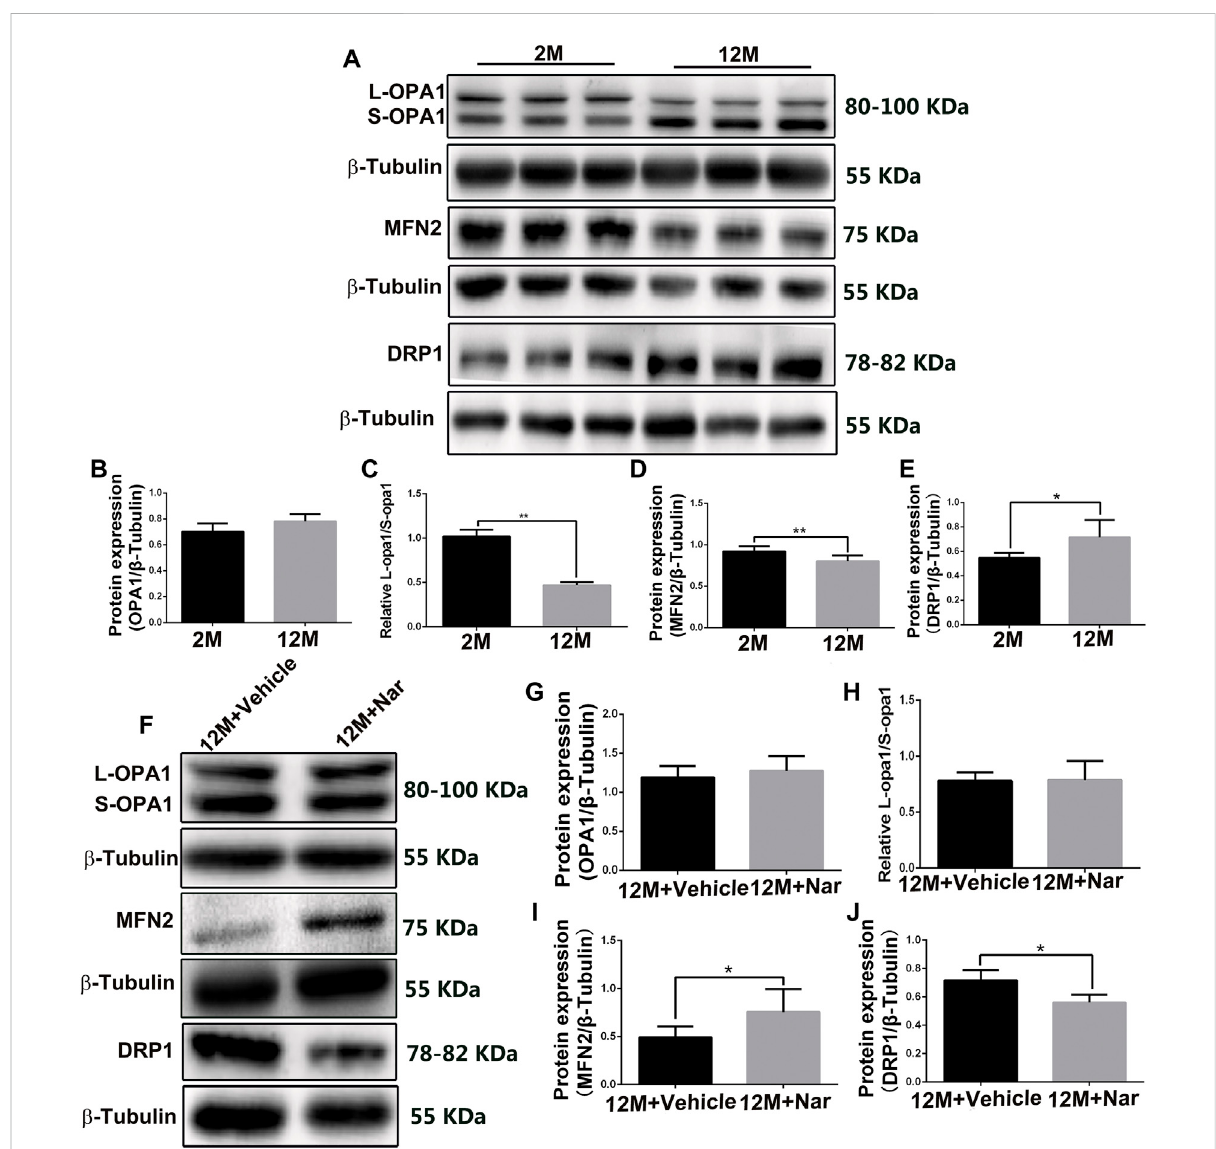
FIGURE 3 Naringeninpromotedmitochondrialfusionanddecreasedmitochondrialfragmentationinagingmice. (A) RepresentativewesternblotofOPA1, MFN2, and DRP1 at different ages. Graphic representation of average fold changes in (B) OPA1, (C) L-OPA1/S-OPA1, (D) MFN2, and (E) DRP1 protein expression. (F) Representative western blot of OPA1, MFN2, and DRP1 in treatment with naringenin, Graphic representation of average fold changes in (G) OPA1, (H) L-OPA1/S-OPA1, (I) MFN2,and (J) DRP1proteinexpression.Theresultsareexpressedasthemeanvalues±SEM, n =5.Unpaired Student ’ s t-test (* p < 0.05, ** p <